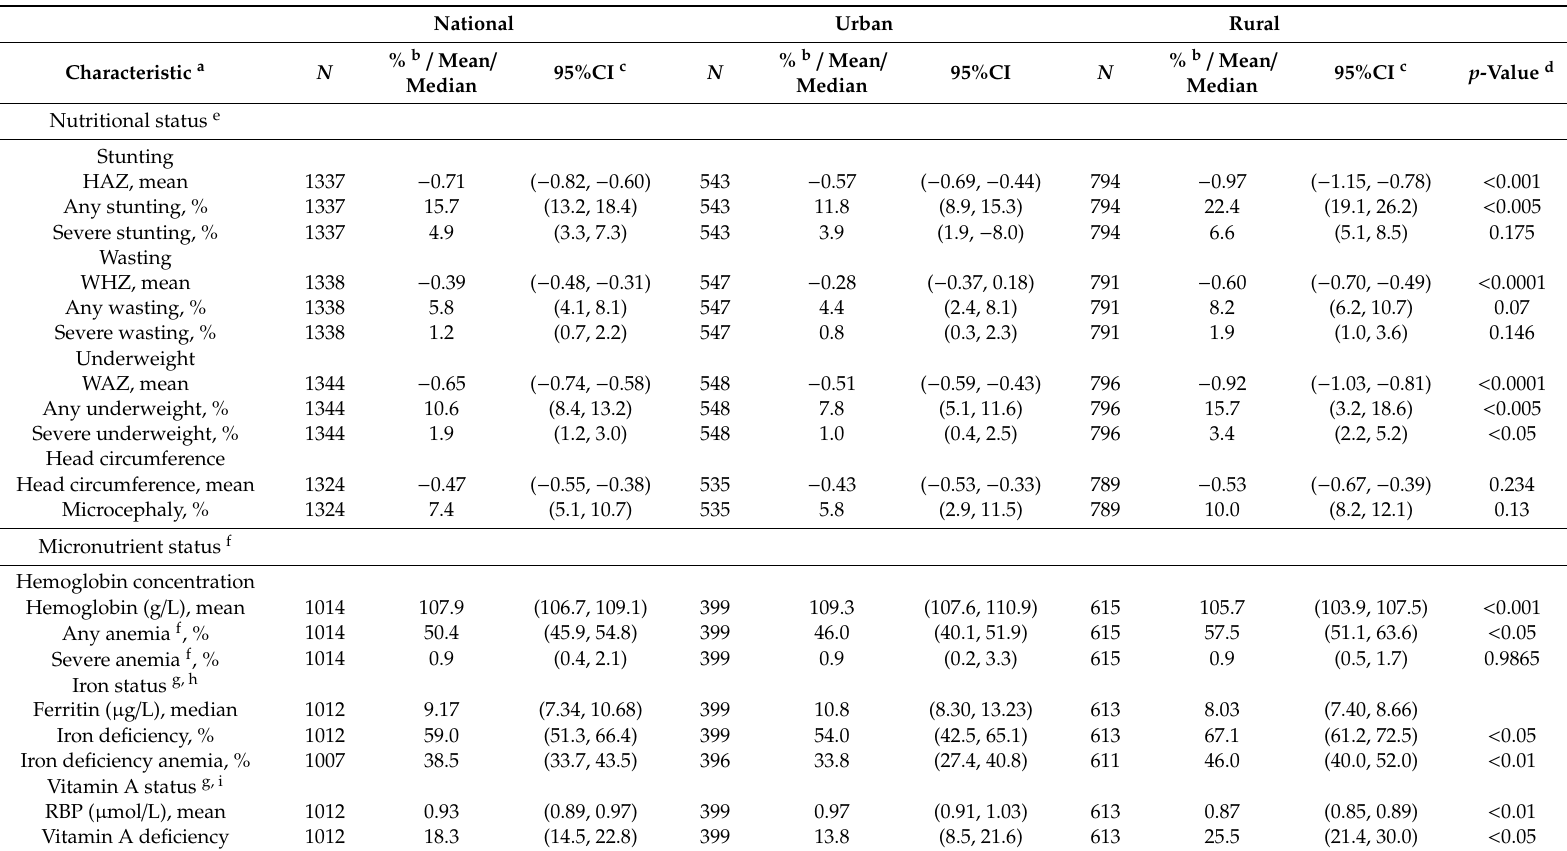
Table 1. Child anemia micronutrient indicators (6–59 months) and anthropometric measures (0–59 months), The Gambia